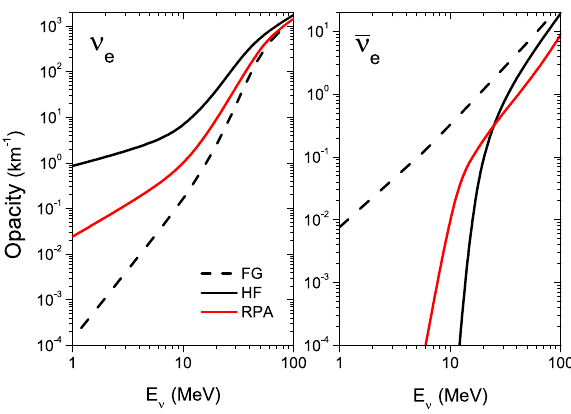
Figure 4. (Color online) Neutrino (left panel) and antineutrino (right panel) opacities, evaluated at beta-equilibrium conditions ρ = 0 . 02fm − 3 , T = 8MeV, and Y force